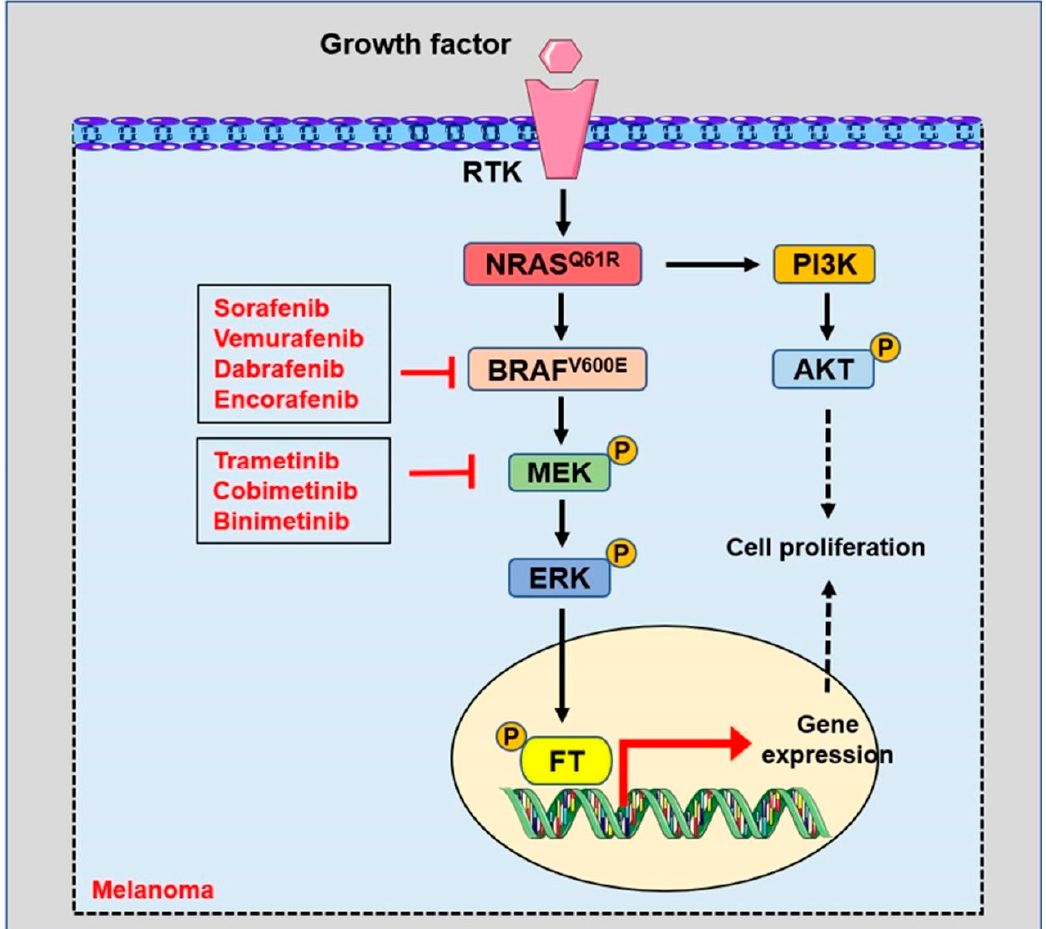
Figure 4. BRAF and MEK inhibitors are used to treat patients with melanoma. ERK: extracellular signal-regulated kinase. MEK: mitogen-activated protein kinase. AKT: protein kinase B. PI3K: phosphoinositide-3 kinase. FT: transcription factor. P: phosphorylated.